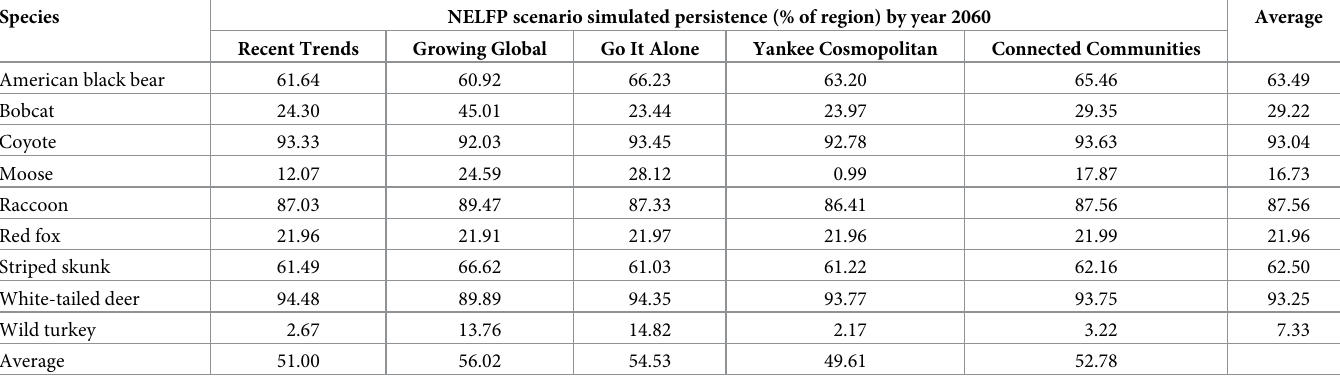
Table 2. Persistence statistics for nine wildlife species in New England, USA.